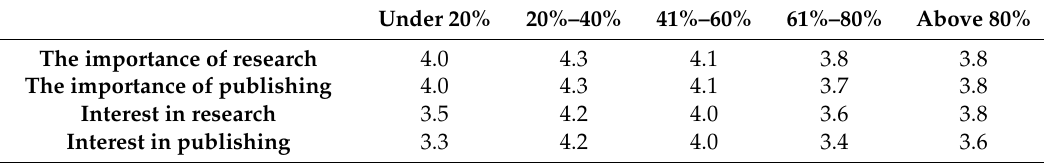
Table 3. Mean scores of the importance and interest in research and publishing across times for